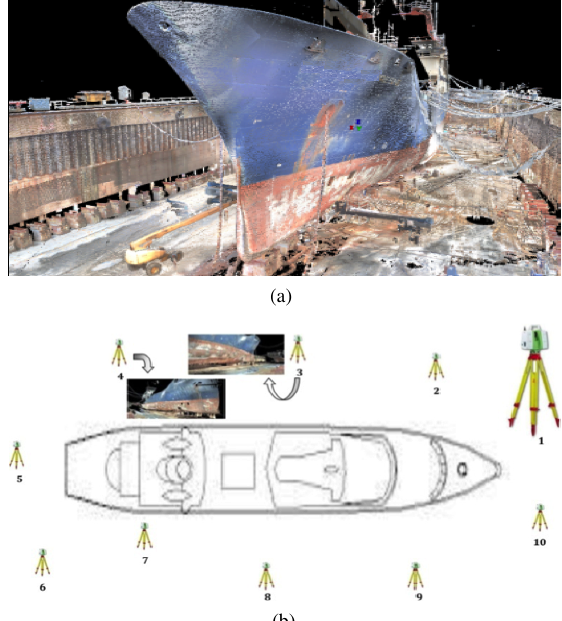
Figure 1. (a) shows the complete 3D point cloud of the ship and the docking area before the filtering phase. Each 3D point is cou- pled with the corresponding R , G & B value. (b) shows the 10 different scanning positions (and different viewing angles), of P20 laser scanner, used to scan the complete